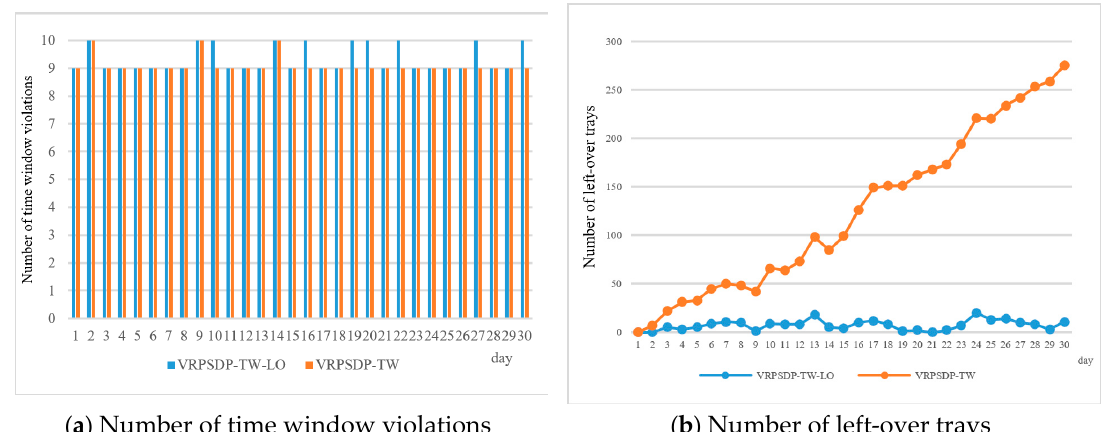
Figure 5. The comparison of a case study of time penalty and left-over tray.